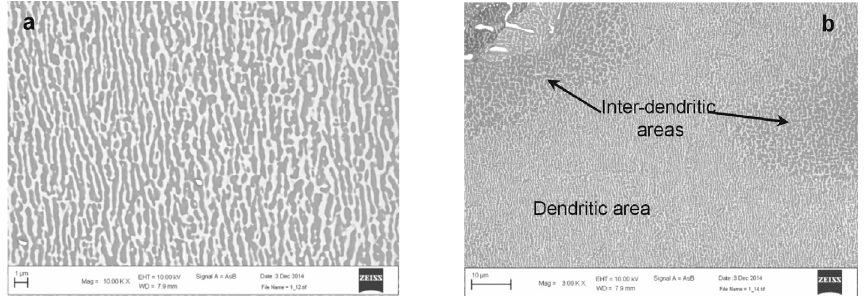
Fig. 6. The microstructure of blade No. 2, the upper longitudinal section: a) dendritic area, visible rafting phenomenon, b) dendritic and inter-dendritic area, SEM